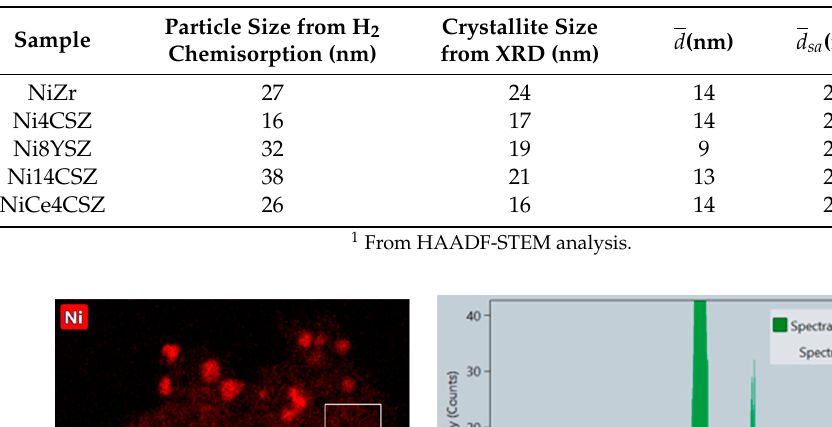
Table 5. Particle size results from electron microscopy analysis. For a better comparison, results from H 2 chemisorption and XRD line broadening are also included.